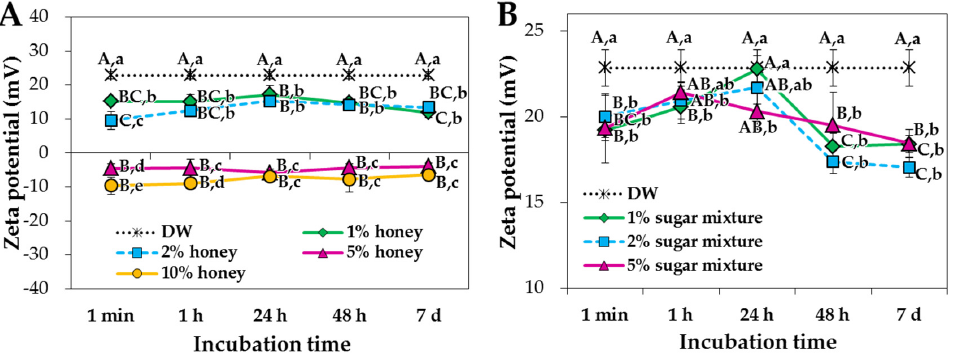
Figure 3. Zeta potentials of ZnO NPs in different concentrations of ( A ) honey and ( B ) sugar mixtures. Different capital letters (A–C) indicate significant differences between incubation times at the same concentration ( p < 0.05). Different lower-case letters (a–e) indicate significant differences between concentrations after the same incubation time ( p < 0.05). Sugar mixtures consist of equivalent amounts of fructose, glucose, sucrose and maltose.